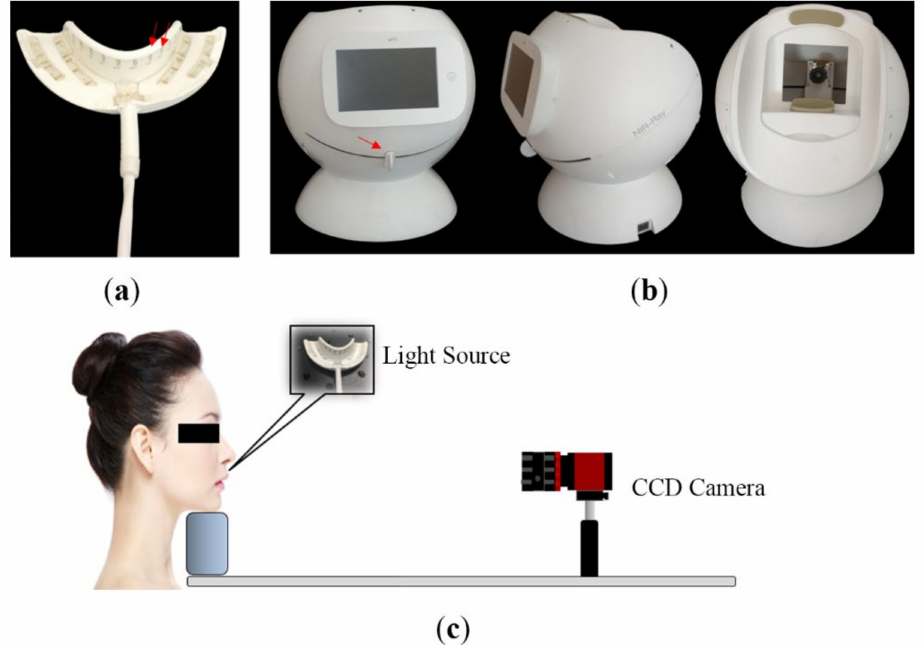
Figure 1. Device and method of detection. ( a ) Rubber tray, which could emit 850 nm Near-IR in the mouth to highlight the cracks. Red arrows indicate the LED illuminant, whose brightness can be adjusted from level 1 to 5, with 5 being the brightest. ( b ) Near-infrared dental and periodontal imaging device with a screen on the examiner’s side for image capturing and a CCD camera inside for image acquiring. Red arrow indicates a control lever, which is connected to the camera to adjust its direction during the detection process. ( c ) Schematic diagram of the patient position during